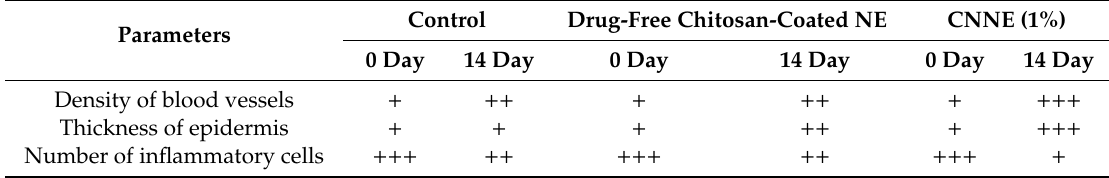
Table 8. Comparative representation of histopathological data for di ff erent treatment groups. Control Drug-Free Chitosan-Coated NE CNNE (1%) Parameters 0 Day 14 Day 0 Day 14 Day 0 Day 14 Day Density of blood vessels + ++ + ++ Thickness of epidermis